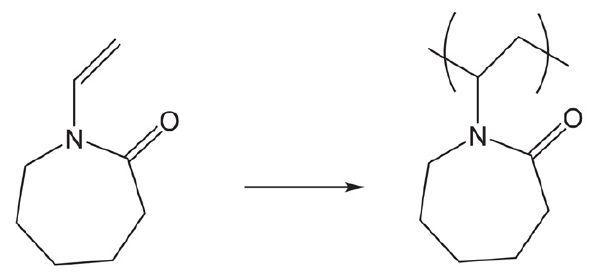
Figure 1. Synthesis of poly(N-vinyl